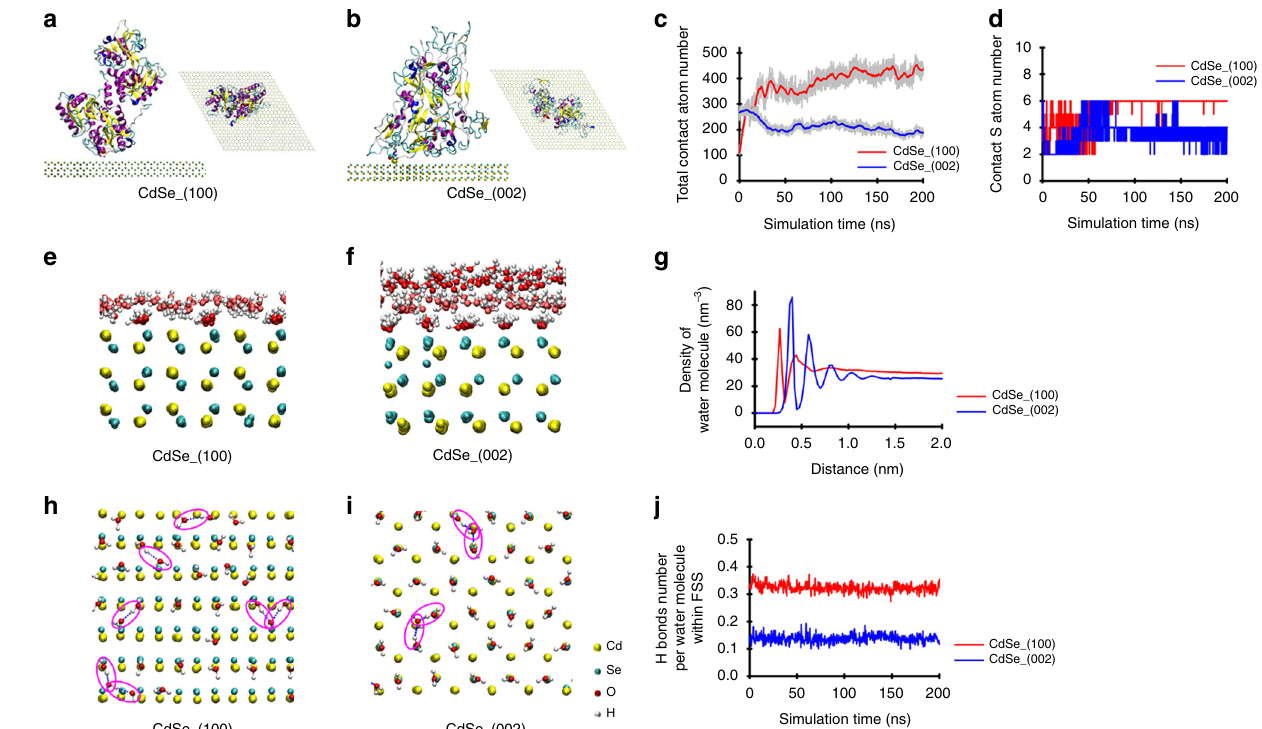
Fig. 5 Molecular dynamics (MD) simulation of interaction between transferrin with CdSe (100) and (002) facets. Conformation of transferrin was different on (100) facet ( a ) and (002) facet ( b ), which resulted in different total contact atom number ( c , CdSe_(100): red solid line; CdSe_(002): blue solid line) and contact sulfur atom number ( d , CdSe_(100): red solid line; CdSe_(002): blue solid line). Snapshot of water molecule layers ( e , f ), number density of water molecules along the z -direction ( g , CdSe_(100): red solid line; CdSe_(002): blue solid line), and the network ( h , i ) and number ( j , CdSe_ (100): red solid line; CdSe_(002): blue solid line) of hydrogen bonds in the fi rst solvation shell of CdSe (100) and (002) facets. The hydrogen bonds were shown as blue dash lines and highlighted in purple circles ( h , i ). Source data are provided as a Source Data fi